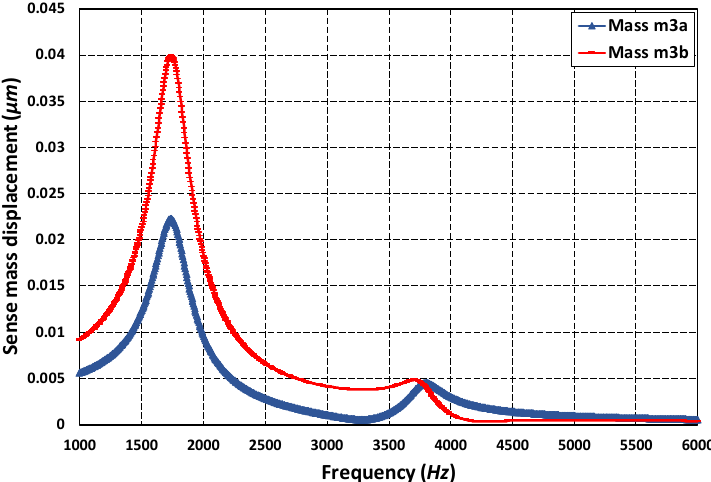
Figure 10. The frequency response of the 2-DoF sense mode oscillator.